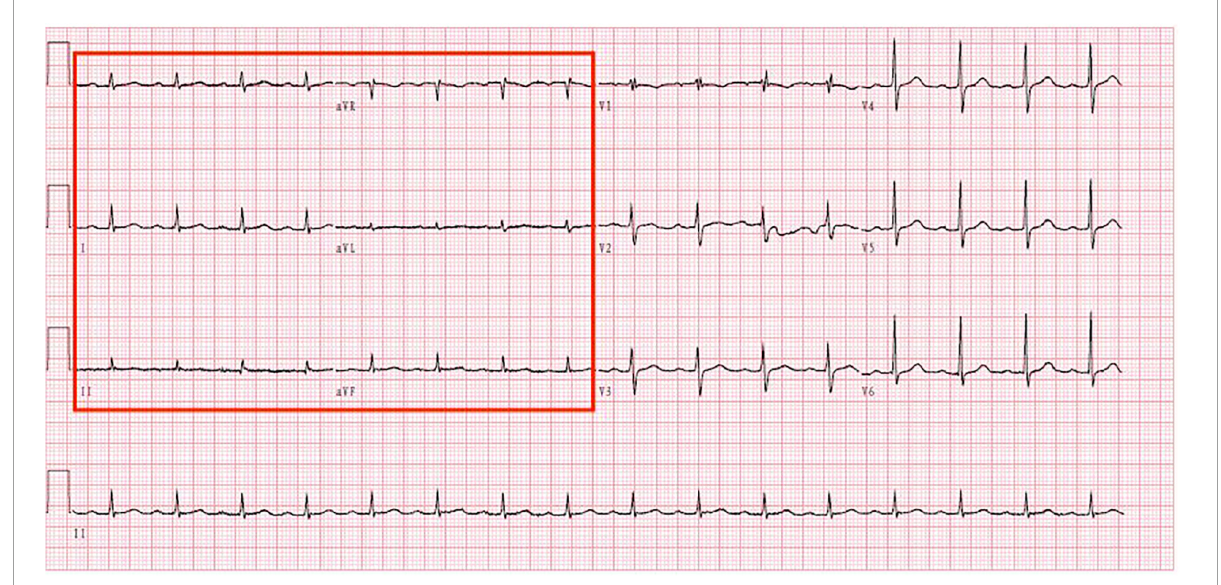
FIGURE1 Electrocardiogram shows that the patient has low voltage in the limb